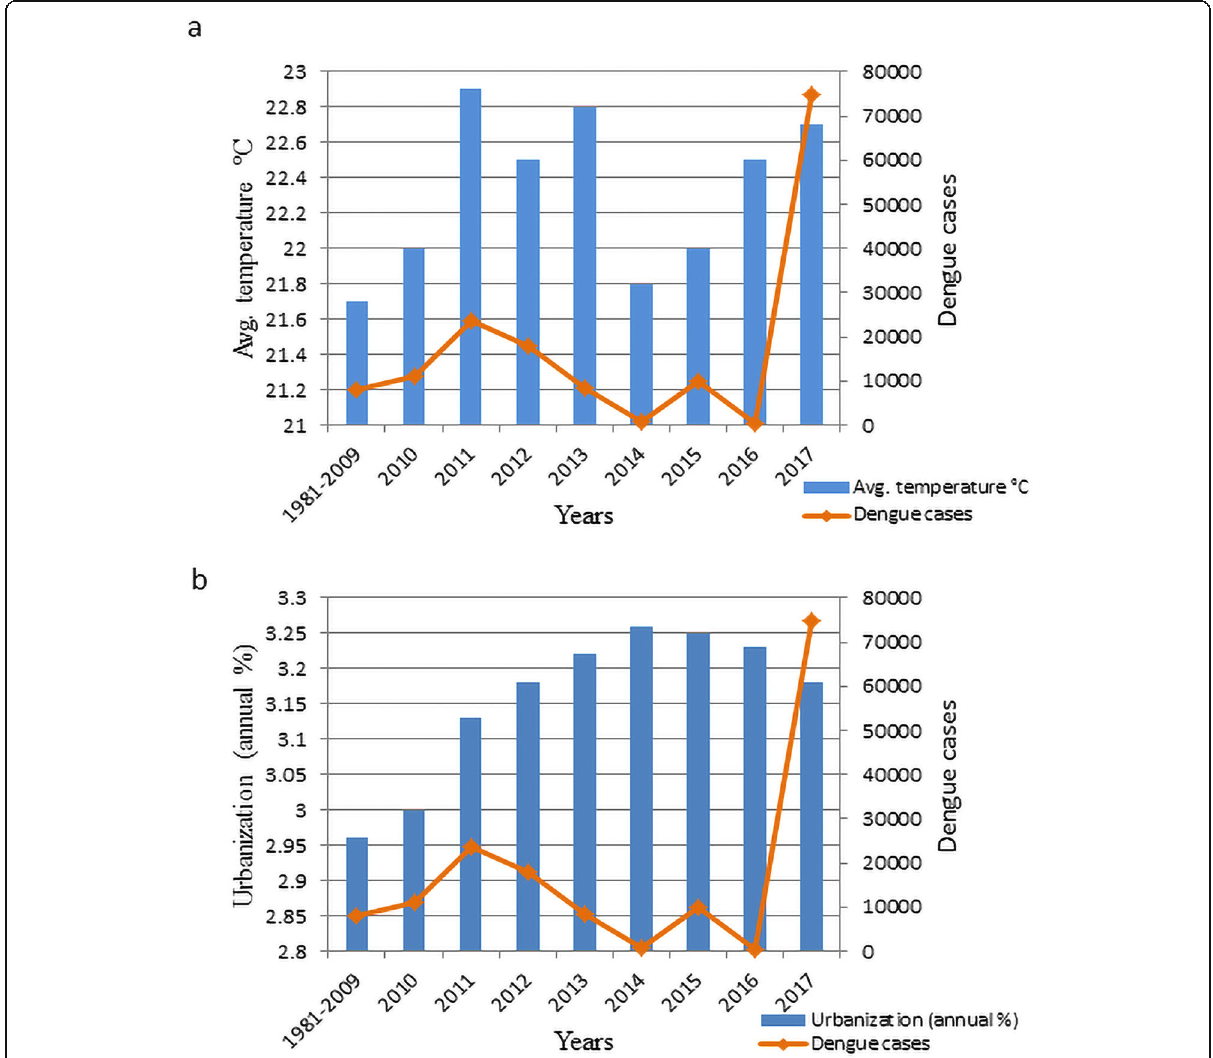
Fig. 1 A graphical representation of the association of temperature ( a ) and urbanization ( b ) with dengue cases. Temperature data were collected from ‘ Annual report of Pakistan Meteorological Department ’ (http://www.pmd.gov.pk/)and urbanization annual % data from ‘ Pakistan Urban Population Growth Annual Percent-Trading Economics